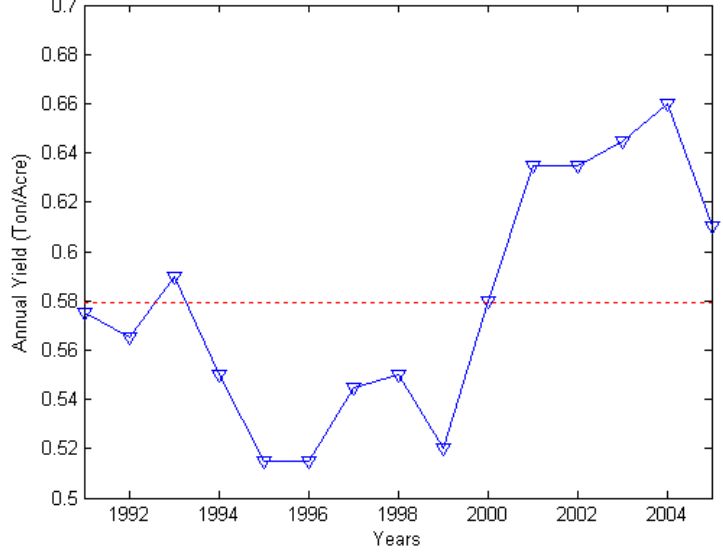
Figure 1. Yield of aus rice per acre in Bangladesh for 1991-2005 and its mean value (dashed